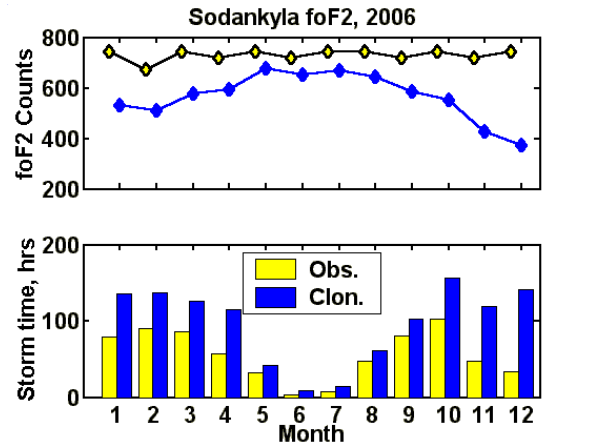
Fig. 6. Diurnal variation of the percentage of the ionospheric storm times at the solar minimum year for the negative ionospheric storms ( W ≤− 3) and positive ionospheric storms ( W ≥ +3) at three stations shown in Fig. 5.